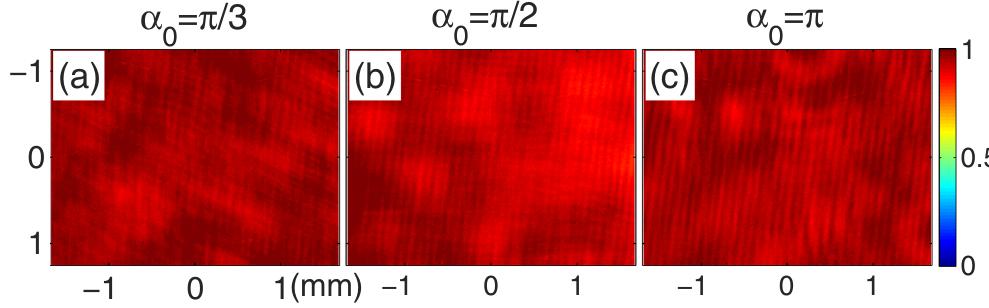
Figure 3. The experimental results of the normalized averaged intensity distributions for ( a ) α 0 = π /3, ( b ) = π /2, and ( c ) α = π α 0 0 Figure 2(b,e,h) are the experimental results of two-photon correlation function → → → = = detectors move together x x x 1 2 , for α 0 = π /3, π /2, and π , respectively. There is only one group of fringes in each pattern, and these two-photon interference fringes vary with the rotation angle α 0 . We can see from Fig. 2(b,e,h) that the fringes are rotated by respective angles 2 π /3, 3 π /4, and π , and the fringe spacings are enlarged with respective enlargement ratios 0.8789 ± 0.0031, 0.6902 ± 0.0041, and 0.5029 ± 0.0043, compared with normal interference fringes. The two-photon interference fringes in Fig. 2(h), in fact, are the subwavelength interference fringes as in ref. 10. Moreover, the fringe visibility degrees are 0.1114 ± 0.0053, 0.1256 ± 0.0042, and 0.1270 ± 0.0013 in Fig. 2(b,e,h), respectively. By adjusting the rotational angle, we can therefore manipulate the